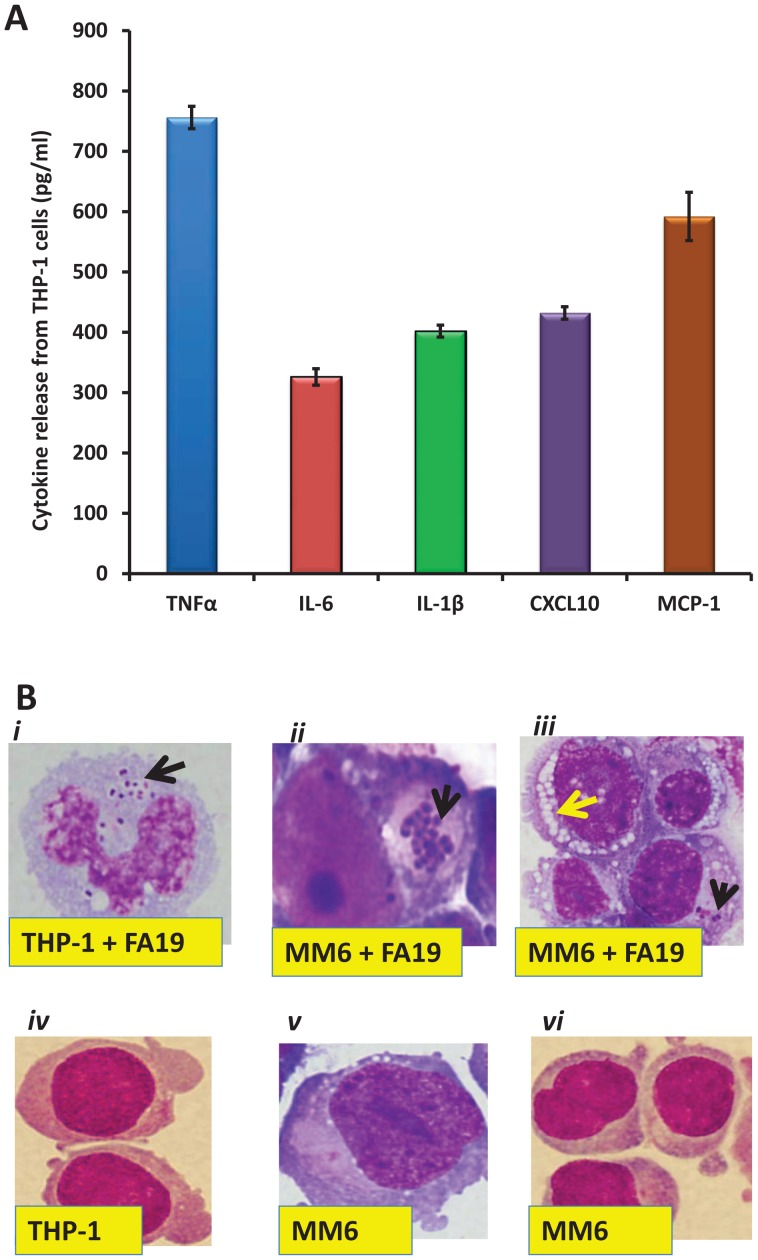
Cytokine release from THP-1 cells infected with N. gonorrhoeae strain FA19.
A. Human macrophage-like monocytic THP-1 cells were infected with GC-FA19 at an MOI of 10 and incubated overnight. Released cytokines TNFα, IL-6, IL-1β and chemokines CXCL10 (IP-10) and MCP-1 were quantified in the supernatants of infected THP-1 cells using ELISA. Cytokine release was not detectable in the supernatants of uninfected THP-1 cells. Error bars represent the SD from the mean of triplicate readings and data are representative of three independent experiments. B. Intracellular gonococci (black arrows) were visualized by differential staining of infected THP-1 (i) and MM6 (ii) cells showing cytoplasmic vacuoles (yellow arrow) (iii) indicating monocyte activation and differentiation into macrophage-like cells, shown in the upper panel. Uninfected THP-1 (iv) and MM6 (v, vi) cells are shown in the lower panel.